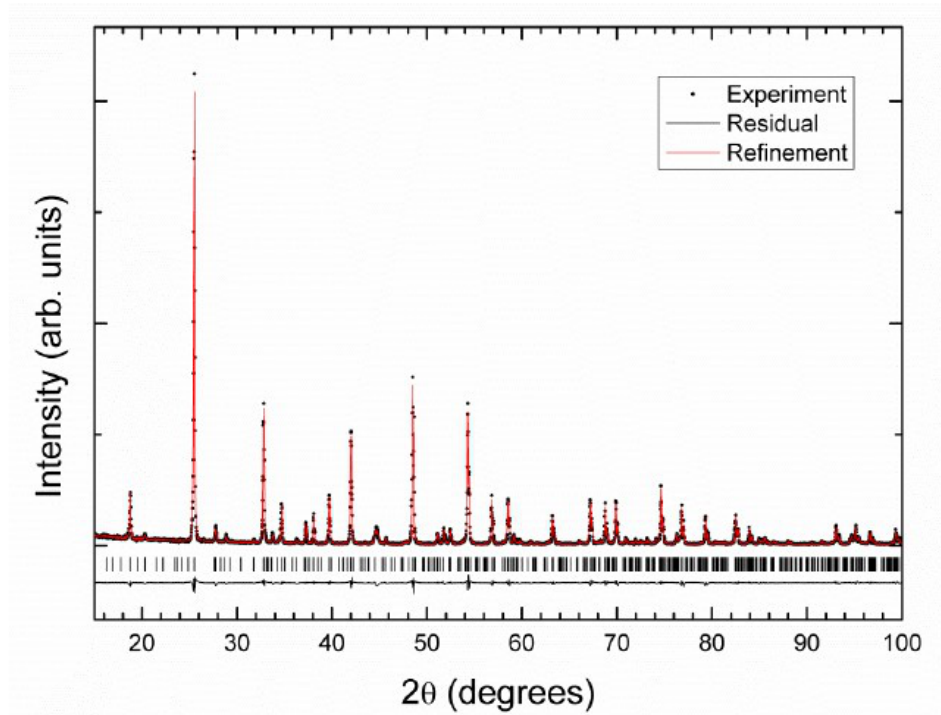
Figure 2. XRD pattern of LiZn(IO 3 ) 3 measured using Cu K α 1 ( λ = 1.54056 Å) and K α 2 ( λ = 1.54443 Å) radiation. Dots correspond to the experiment. The Rietveld refinements, carried out assuming DFT-calculated atomic positions, are shown with a red solid line. The residuals are plotted with a black solid line. Positions of the Bragg peaks are indicated by black ticks.